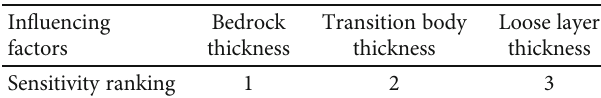
Table 7: Sensitivity ranking of each in fl uence factor.